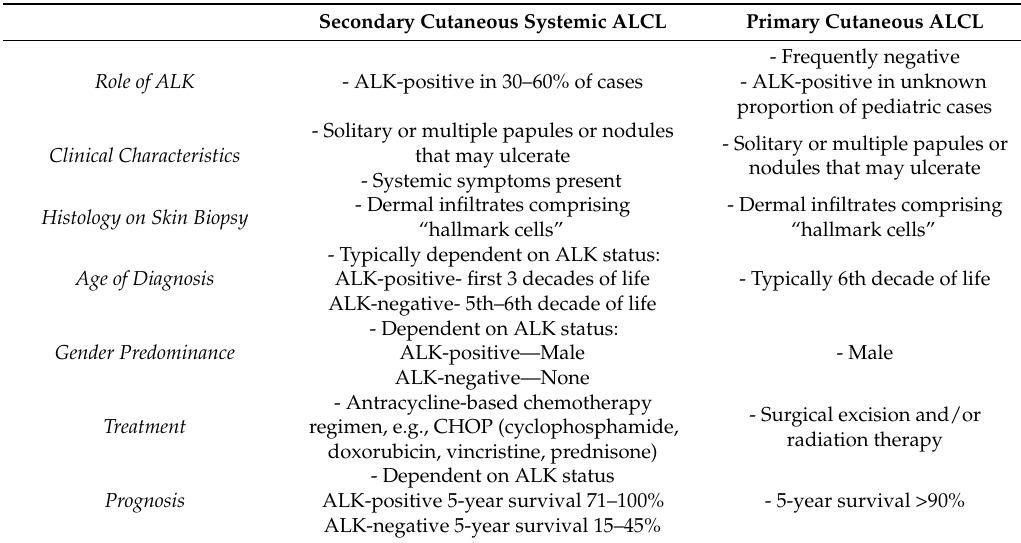
Table 1. Similarities and differences between secondary cutaneous systemic anaplastic large-cell lymphoma (ALCL) and primary cutaneous